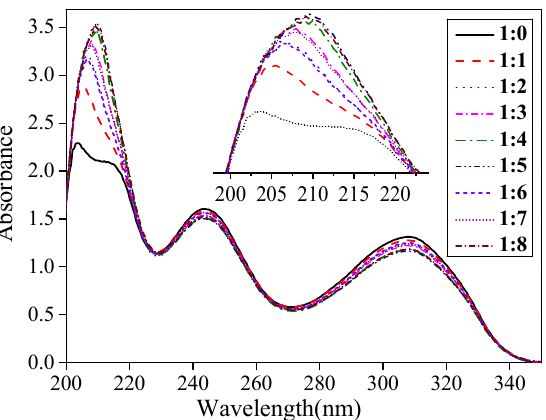
Figure 4. UV absorption spectra of CAP and MAA mixed at different molar ratios in DMSO. To confirm the interaction between template CAP and MAA, FT-IR was used to study the CAP-MAA host-guest complex. As shown in Figure 5a, the peaks at 3530, 1710, and 1635 cm − 1 correspond to the stretching vibration peaks of the carboxy hydroxyl group, carbonyl group, and C=C double bond, respectively. Simultaneously, the C-H out-of-plane bending vibration peak of the double bond in the MAA molecule appeared at 790 cm − 1 . As shown in Figure 5b, the peaks at 3500, 1750, 1650, and 1313 cm − 1 arise from the expansion vibration of the hydroxyl group in CAP, base, amide bond, and C-F expansion vibration, respectively. As shown in Figure 5c, when the template molecule CAP was added at the same concentration, the C=O stretching vibration peaks of CAP and MAA shifted to 1702 cm − 1 , while the C-O stretching vibration peaks of CAP moved from 1204 to 1184 cm − 1 . A new absorption peak also appeared at 2555 cm − 1 , indicating that the hydroxyl groups in CAP and MAA underwent a novel hydrogen-bond formation. The above evidence confirms that CAP and MAA form hydrogen-bonding interactions.